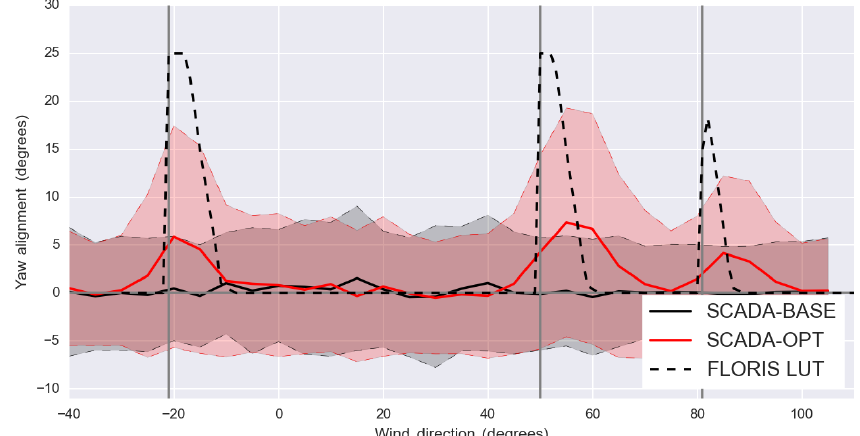
Figure 5. Statistical analysis of the SCADA vane data from turbine C1, with the offset controller off and on. This graph shows the controller of turbine C1 operating to redirect the wake away from the downstream turbines. The black and red lines indicate the average yaw offset positions from SCADA data for the baseline and offset strategy, while the dashed lines are those of the look-up table (LUT) from FLORIS. Finally, the red and black regions show the range of points from the 25th through 75th percentiles for the baseline and offset SCADA